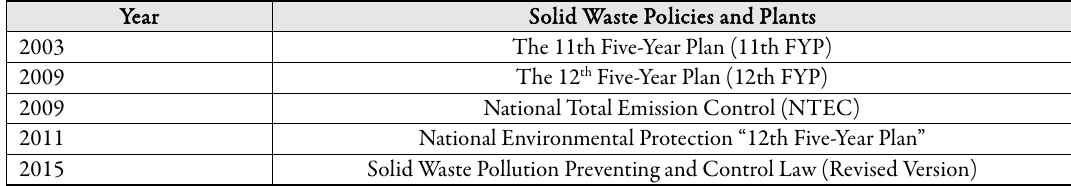
Table 3. National environmental protection plants (Zhou et al .,